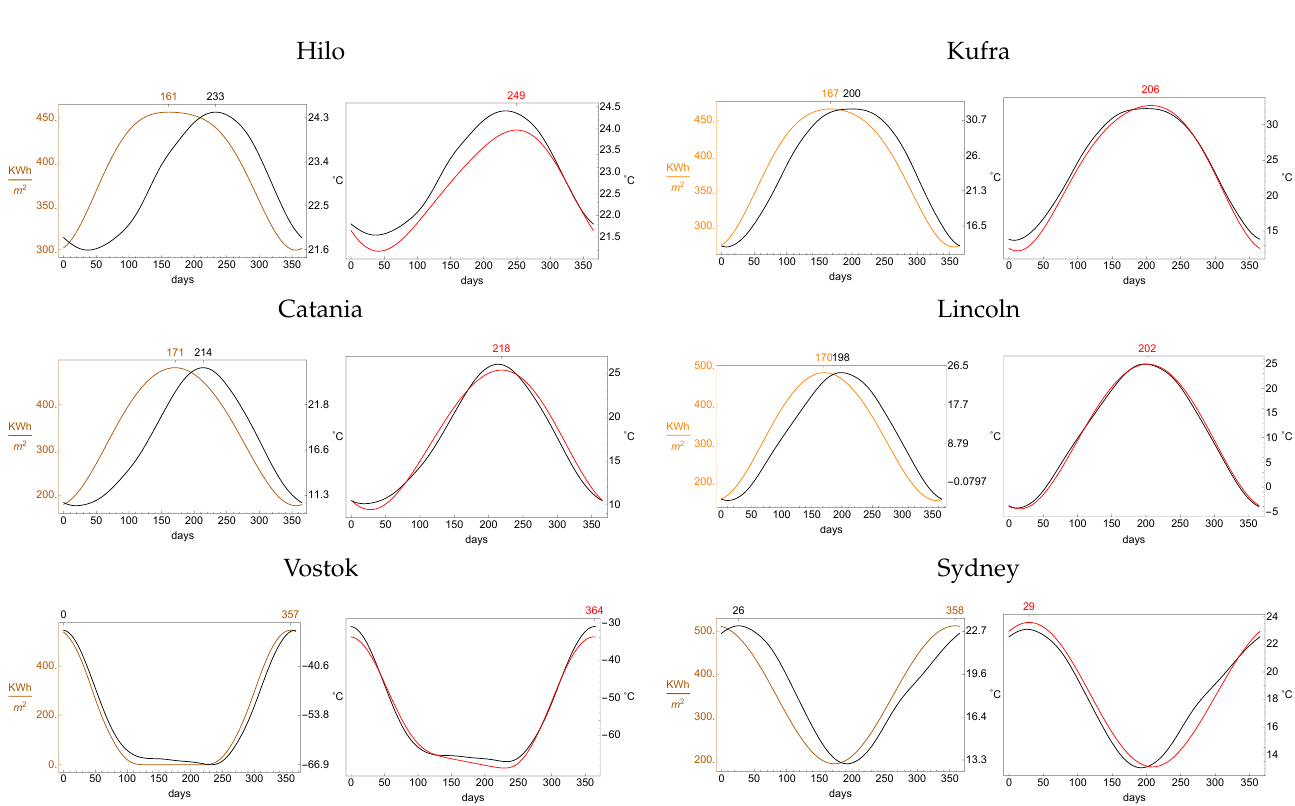
Figure 10. For each location, the left plots displays the daily energy of solar radiation in orange and the average daily temperature in black. The seasonal lag is clearly indicated in the ticks. On the right plot the average daily temperature in black and the simulated average daily temperature in red. The simulated lag is always higher but reasonably similar. Table 9. Average time of daily maximal solar irradiation, and average times of daily maximal temperature measured and simulated. City Max Power of Solar Rad. Max Temp. Max Simulated